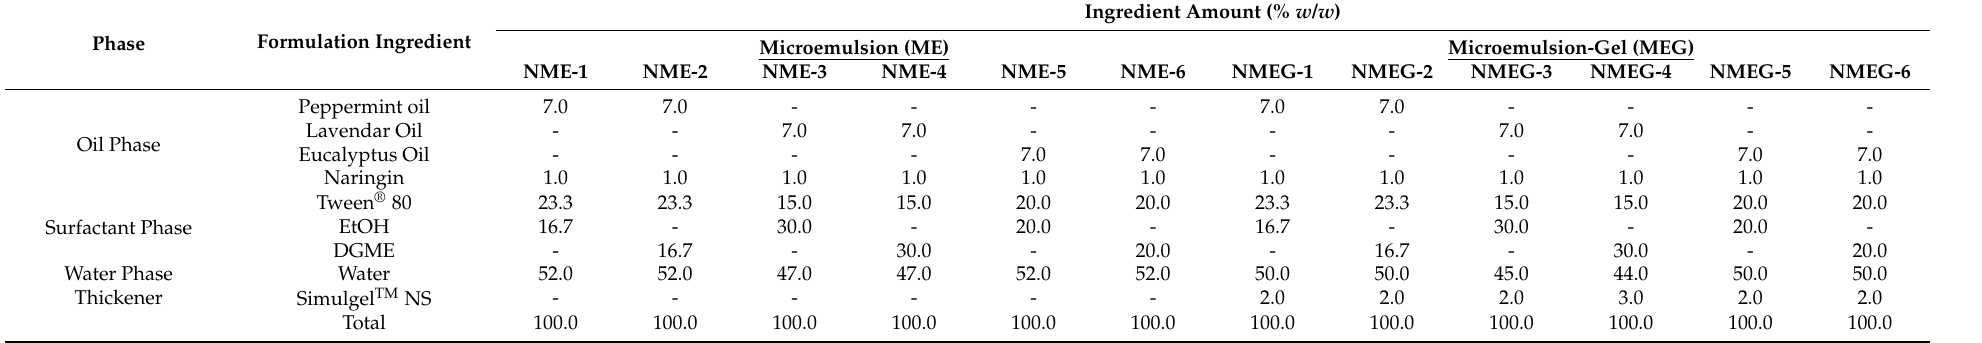
Table 1. Composition of naringin-loaded microemulsions and microemulsion-gel